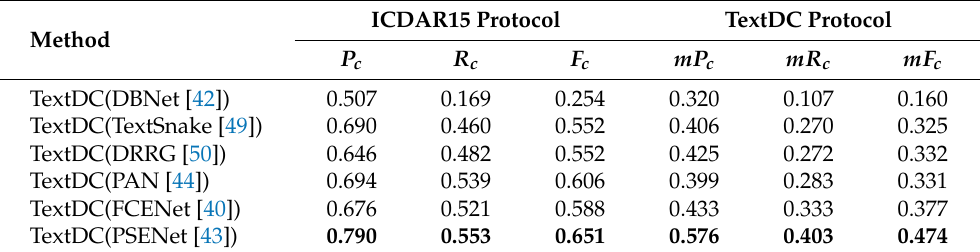
Table 3. Comparison results of the detection and classification performance on the proposed Text3C dataset, evaluated with the ICDAR15 protocols with category constraints [7], and the proposed TextDC protocols. Bold indicates the best performance. ICDAR15 Method